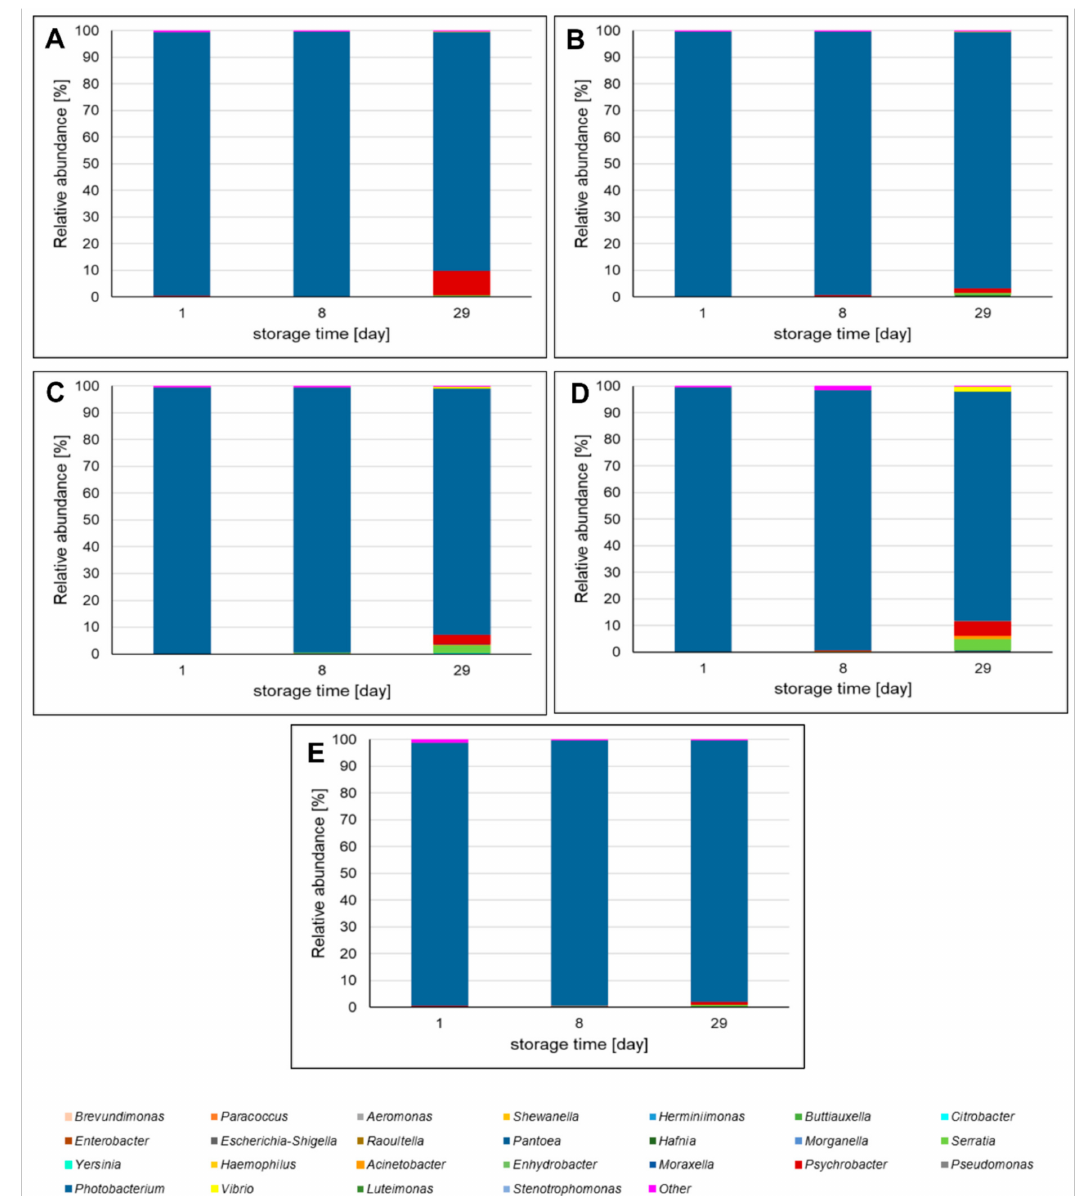
Figure 3. The most abundant genera among Proteobacteria phylum identified in pork sausages stored in MAP at 4 ◦ C based on high-throughput sequencing of the 16S rRNA gene. The results are expressed as percentage share of each bacterial genius making up the total number of identified genera in each sausage sample among Proteobacteria phylum. Bacteria genera with percentage relative abundance >0.01% are shown. ( A )—sausage with Aronia melanocarpa leaf extract; ( B )—sausage with Chaenomeles superba leaf extract; ( C )—sausage with Cornus mas leaf extract; ( D )—sausage with curing salt containing sodium nitrate (III); ( E )—control sausage with salt and spices only (without extract and nitrates (III)). At the start of storage, the Firmicutes phylum was mainly represented by Carnobac- terium sp. (50.30–65.16% of Firmicutes OTUs) (Figure 4). However, during storage, Bro- chothrix sp. came to predominate, constituting after 29 days 70.29–94.65% of Firmicutes OTUs. During storage, the relative abundance of Lactococcus sp., Lactobacillus sp.,